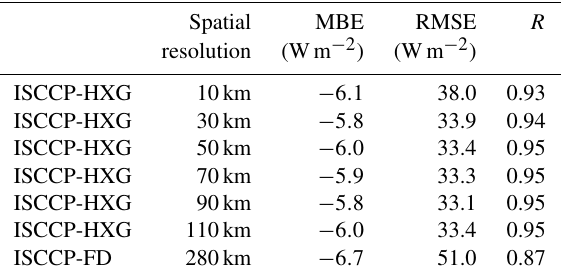
Figure 3. Spatial distribution of RMSE (Wm − 2 ) for our estimated instantaneous SSR (spatial resolution 90km) at 42 BSRN stations. Table 2. Effect of spatial resolution on accuracy of our estimated daily SSR compared to observations at 42 BSRN stations. A com- parison with daily SSR of ISCCP-FD is also